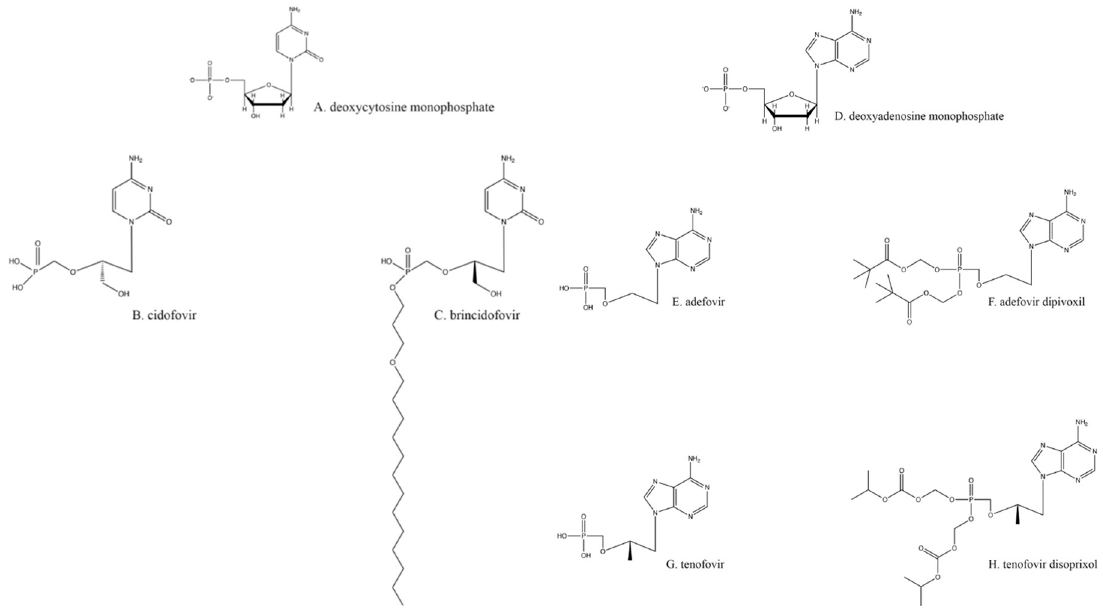
Figure 2. Nucleotide analogs.